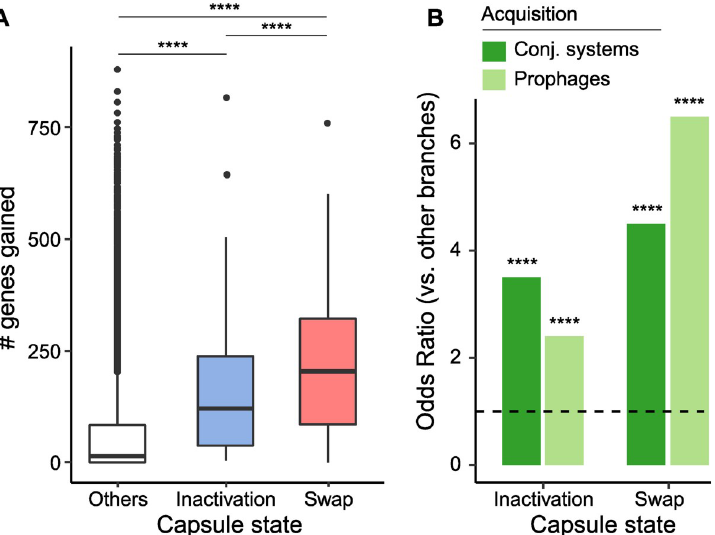
Fig 4. Changes in capsule state impact HGT. (A) Number of genes gained in terminal branches of the phylogenetic tree where the capsule was inactivated, swapped, and in the others (2-samples Wilcoxon tests). (B) Increase in the frequency of acquisition of prophages and conjugative systems on branches where the capsule was either inactivated or swapped, relative to the other branches, as represented by odds ratio (Fisher exact test). ���� : p -value < 0.0001